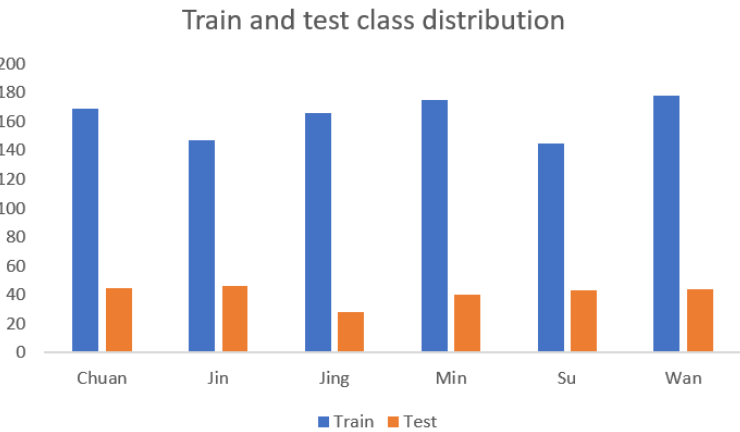
Figure 3. The number of images in the training and test set when using the split ratio of 4:1.